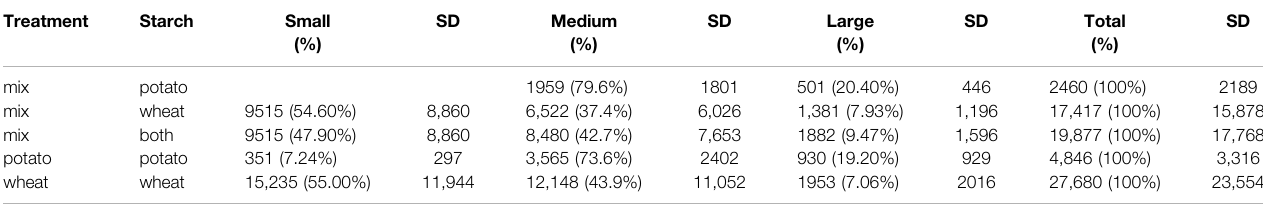
TABLE 3 | Mean starch counts extracted from samples with standard deviation (SD), including the proportion of granule sizes of the total count. Treatment